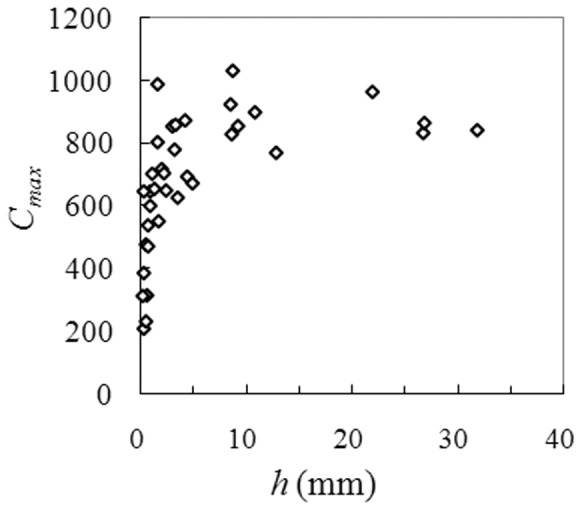
The relationship between C
max and h at the Tuanshangou station, showing that small runoff events also have chances to achieve a high level of sediment concentration.